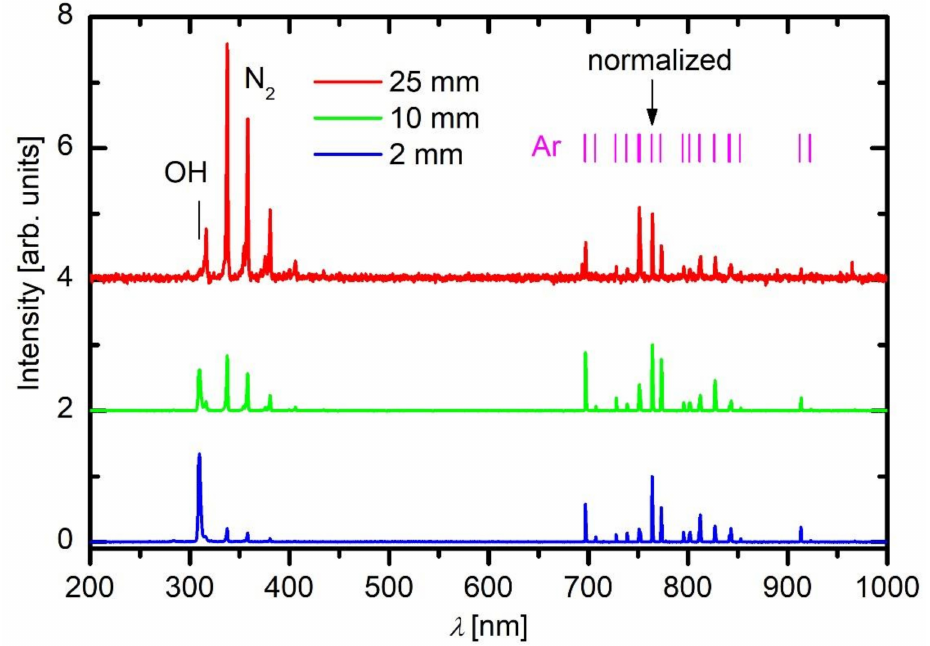
Figure 3. The OES spectra recorded at various distances from the exit of the discharge tube. The spectra were normalized to Ar line at 764